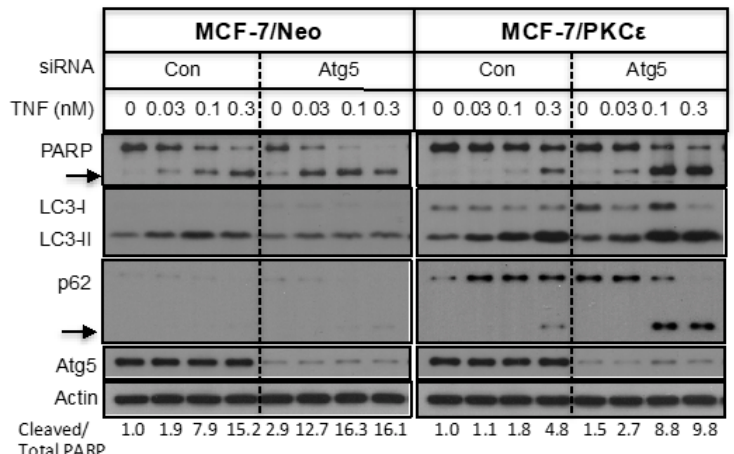
Figure 8. PKC ε promotes cell survival by inhibiting apoptosis and inducing autophagy. Cells were transfected with control or Atg5 siRNA and then treated with different concentrations of TNF. Western blot analyses were performed with indicated antibodies. The arrow indicates cleaved fragments.